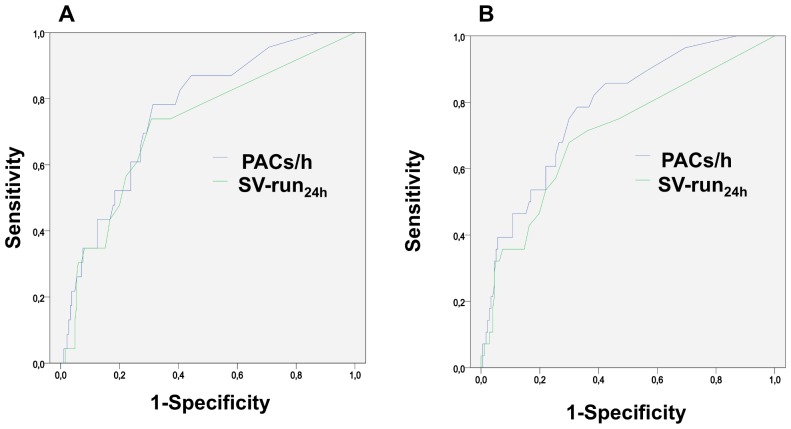
ROC-curves – ESVEA as a predictor of PAF.ROC-curves for PAC/h (blue) and SV-run24 h (green) to detect paroxysmal atrial fibrillation A) in baseline 7-day Holter-monitoring only or B) total PAF after baseline 7-day Holter-monitoring and clinical follow-up (up to 1 year).